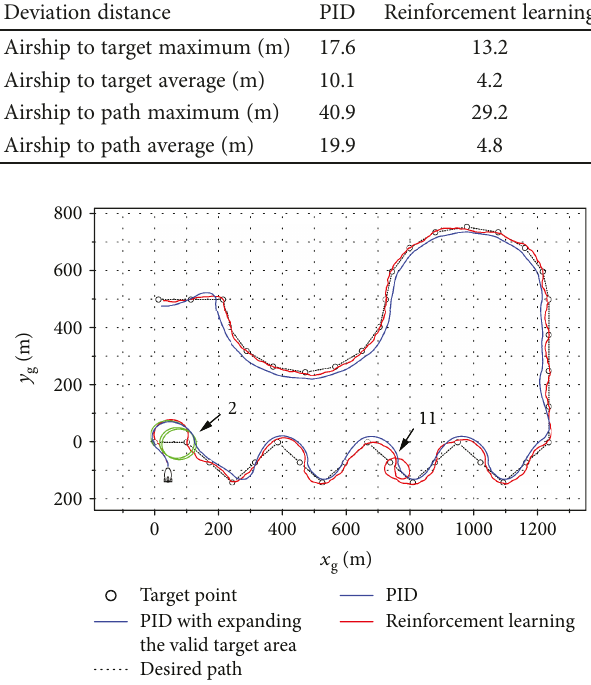
Figure 10: The planar path-following control after the airship ’ s dynamic model